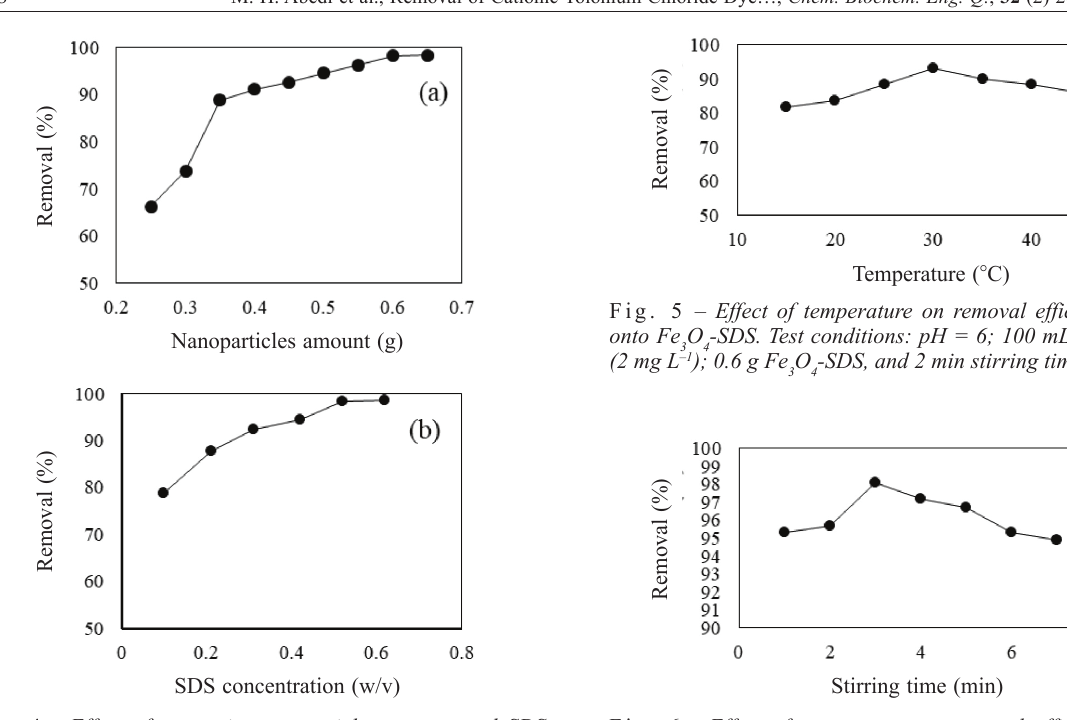
Fig. 4 – Effect of magnetic nanoparticles amount and SDS concentration on removal efficiency of TC onto Fe Test conditions: pH = 6; 100 ml Tc solution (2 mg l –1 ), and 2 min stirring time (100 rpm).